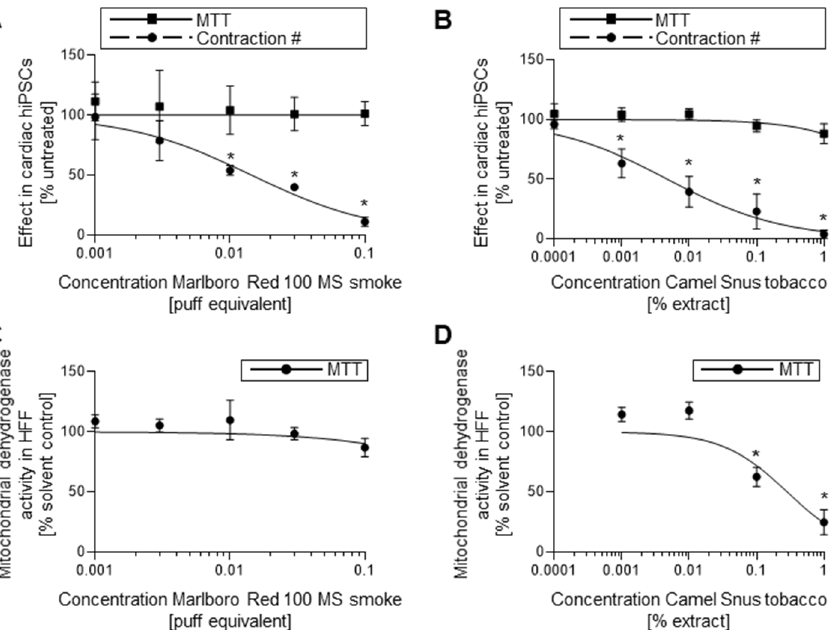
Figure 6. Effects of cigarette smoke and Snus smokeless tobacco on developing cardiomyocytes. ( A ) Contractile and viability screens for hiPSCs exposed to MS cigarette smoke using contractile and MTT assay, n = 3 ± SD. ( B ) Contractile and viability screens for hiPSCs exposed to Snus smokeless tobacco using contractile and MTT assay, n = 3 ± SD. ( C ) Viability screen for hFFs exposed to MS cigarette smoke using MTT assay, n = 3 ± SD. ( D ) Viability screen for hFFs exposed to Snus smokeless tobacco using MTT assay, n = 3 ± SD. hiPSC, human induced pluripotent stem cell; MTT, mitochondrial dehydrogenase activity assay; MS; mainstream; hFF, human foreskin fibroblast. *: p < 0.05 = the lowest concentration significantly below the untreated hiPSC control group as determined by One-Way